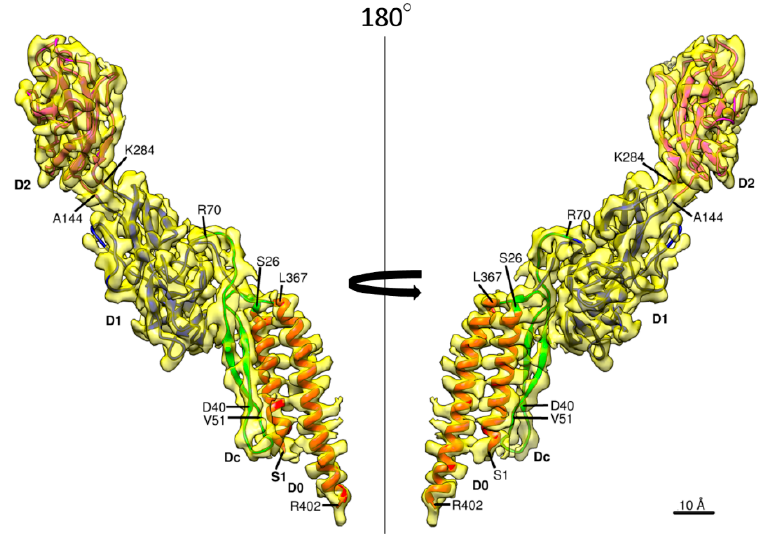
Figure 2. The 3D density map and model of a FlgE subunit. Two side views are shown, with the four domains colored as follows: D0, red; Dc, green; D1, gray; and D2, orange.